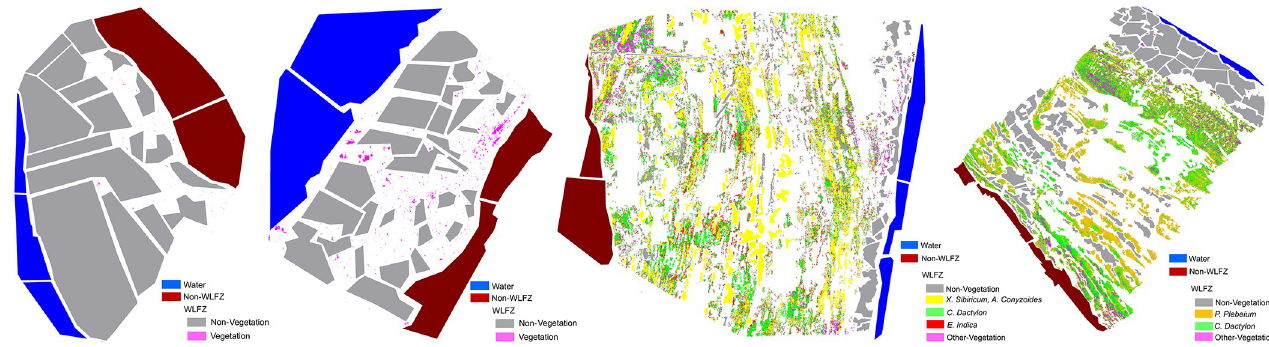
Fig 4. The ground truth reference of (a) Huangdeng 1, (b) Huangdeng 2, (c) Nuozhadu and (d) Xiaowan study